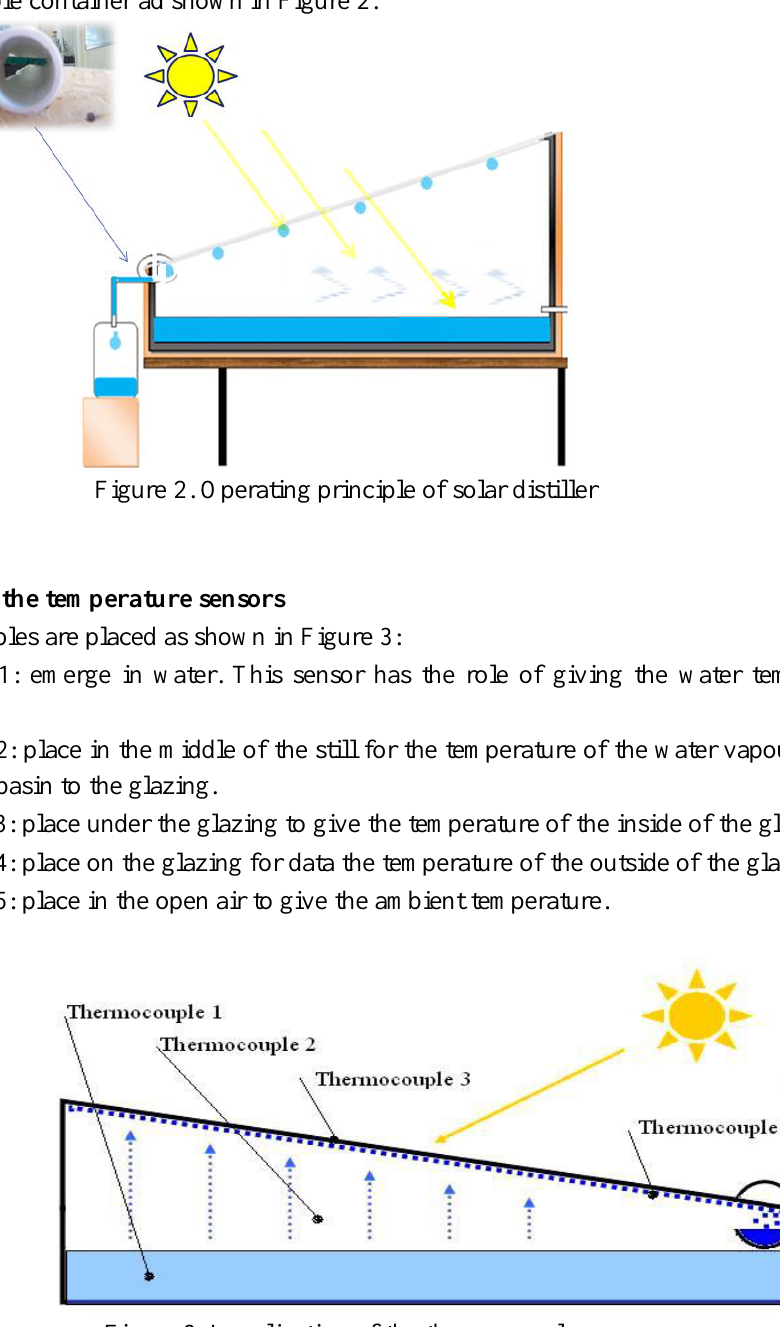
Figure 3. Localization of the